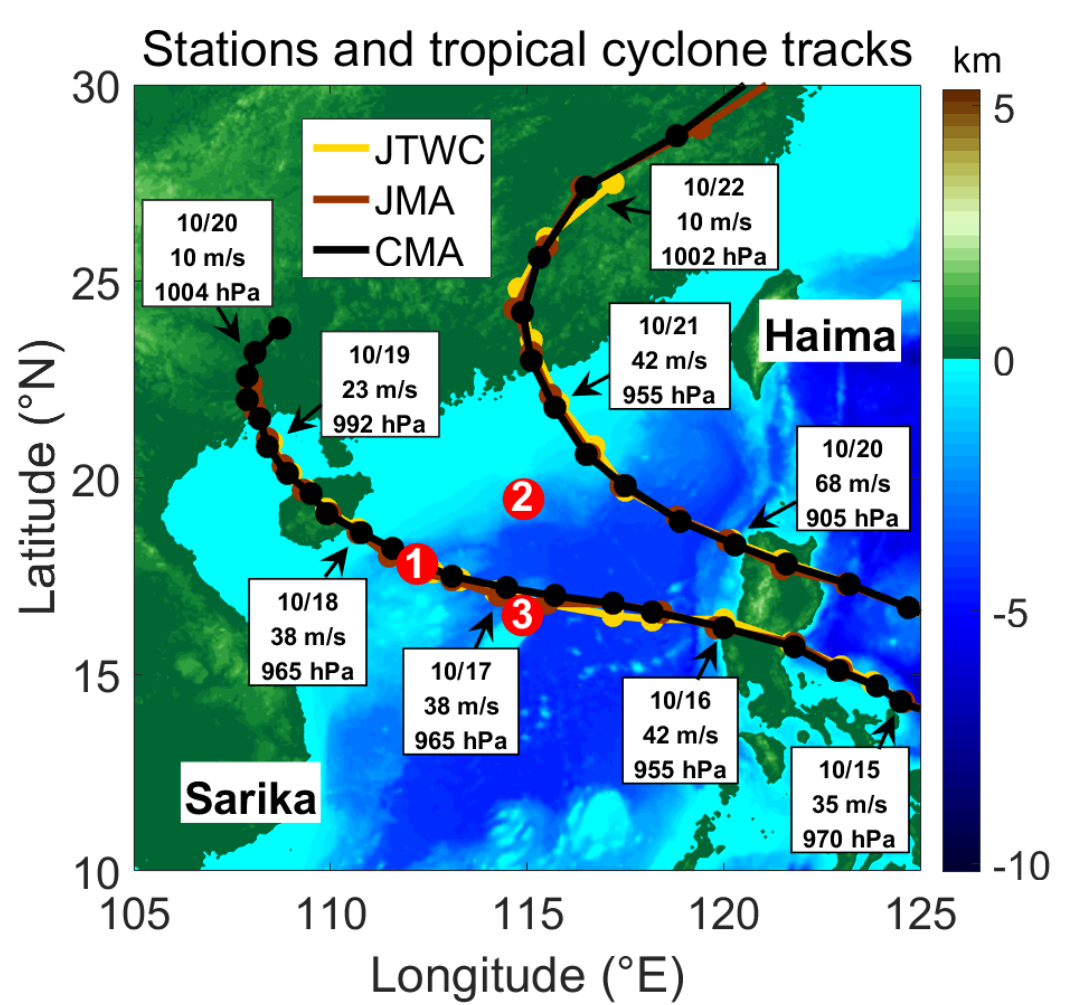
Figure 1. Tracks of Typhoons Sarika and Haima obtained from the Joint Typhoon Warning Center (JTWC) data (orange), Japan Meteorological Agency (JMA) data (brown), and China Meteorological Administration (CMA) data (black), showing their positions every 6 h (dots). The text boxes point to the UTC 00:00 of the positions everyday, show the dates, sustained maximum wind speed, and central pressure obtained from the CMA data. The red numbers indicate the positions of the observation stations. The background shade indicates the